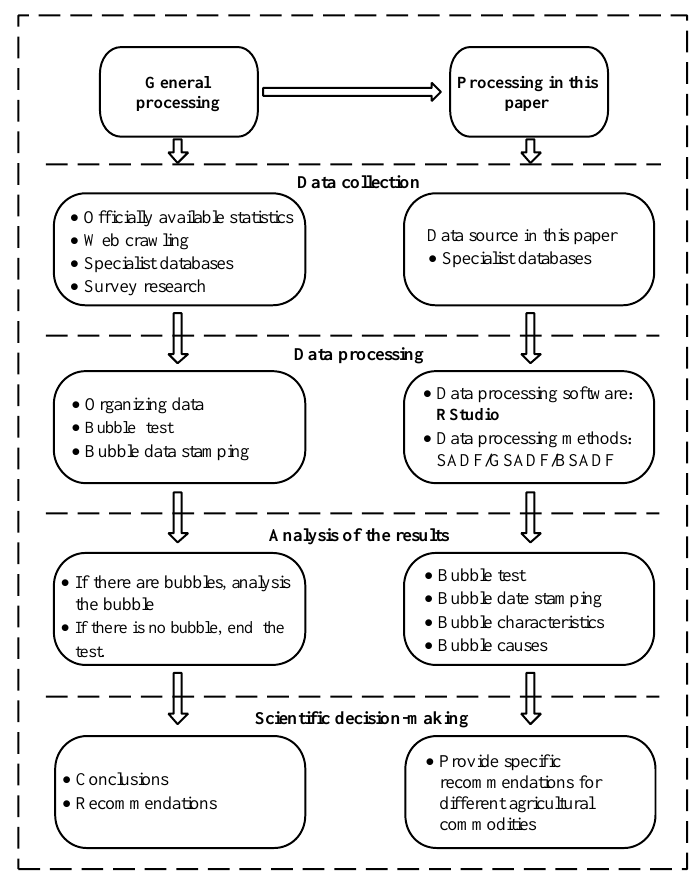
Figure 1. Data processing procedures.